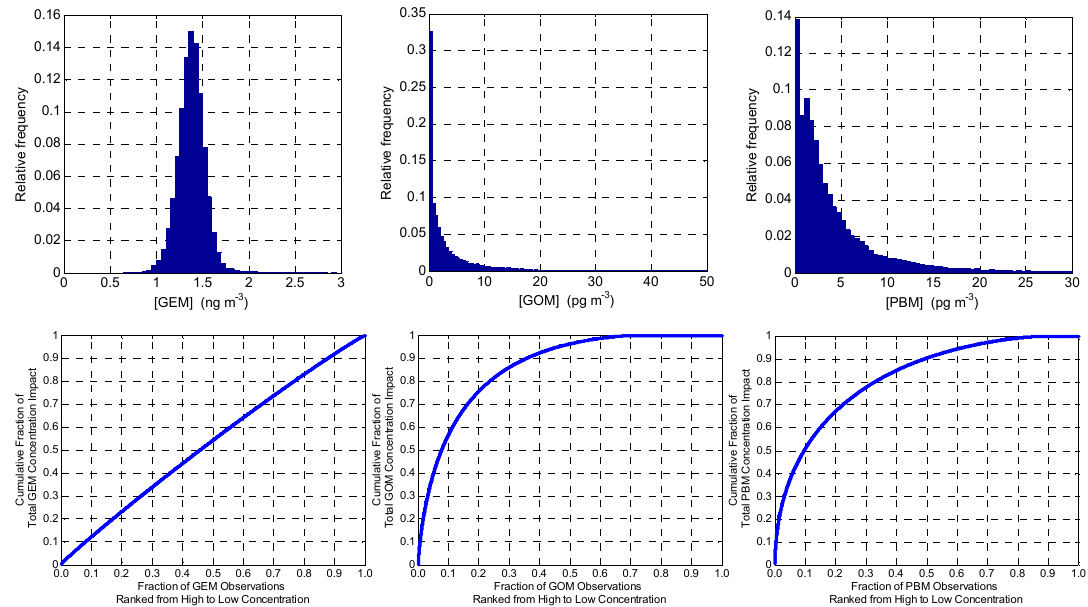
Figure 3. Top panels: Frequency distributions of hourly measurements of GEM ( left ), GOM ( middle ), and PBM ( right ) at the Grand Bay site from 2007 to 2018. All GEM, GOM, and PBM data, including zero values for GOM and PBM concentrations, are plotted. The intervals of the bins are 0.05 ng m − 3 for GEM and 0.5 pg m − 3 for GOM and PBM. Bottom panels: the cumulative concentration as a function of rank for GEM ( left ), GOM ( middle ), and PBM ( right ) concentrations. The y -axis and x -axis are normalized to show fractions of the